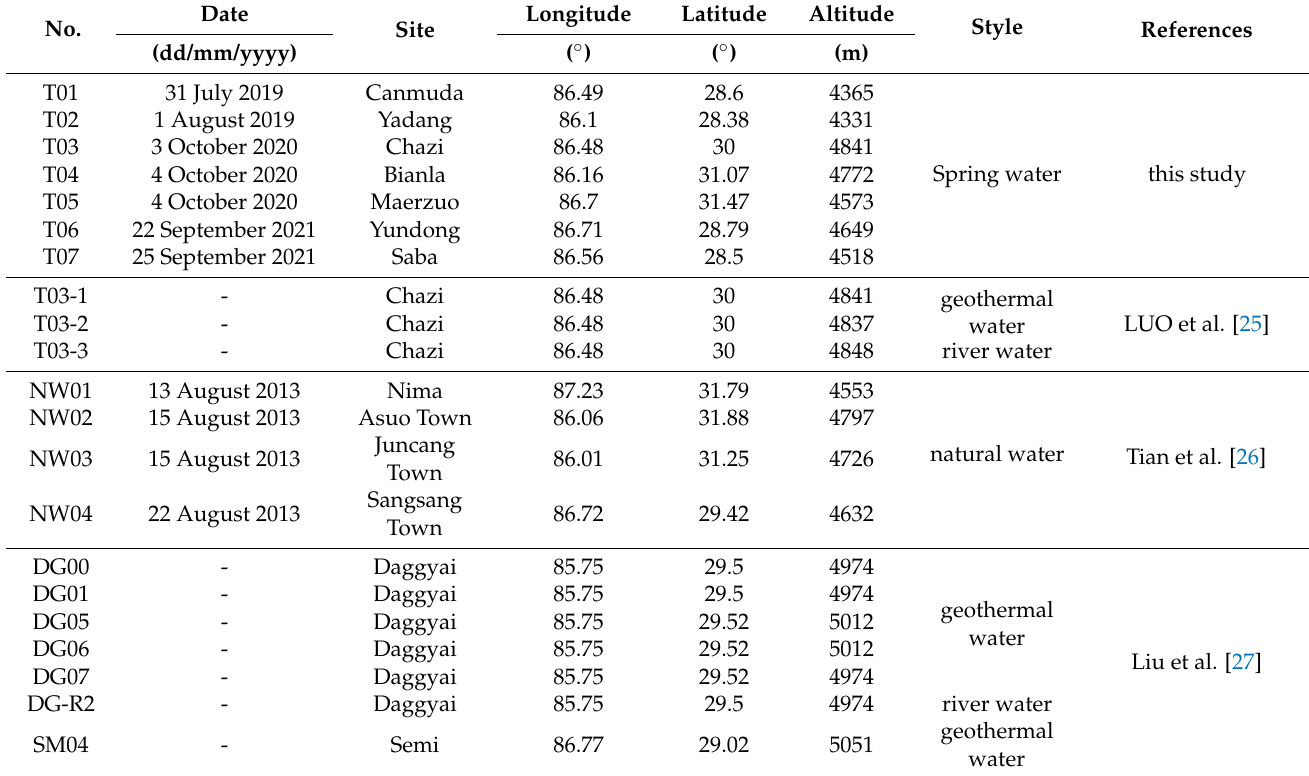
Table 1. Location of the surveyed area of hot springs in the